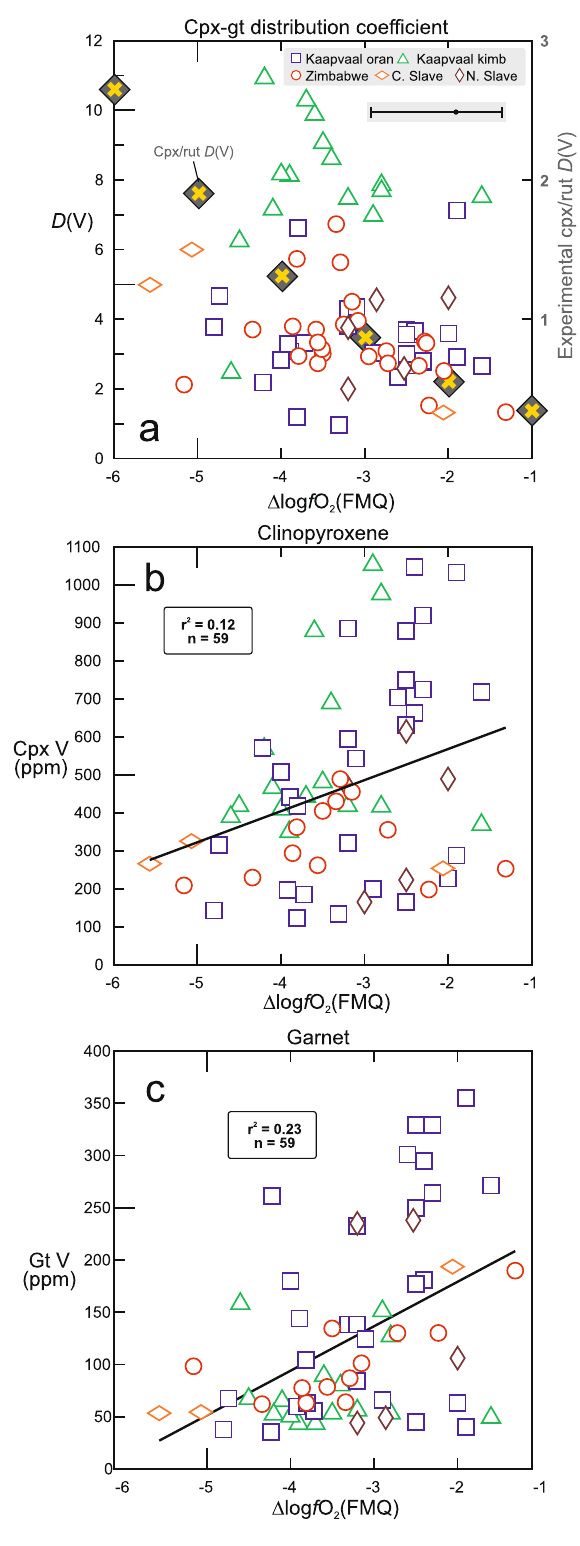
melt protoliths mimics that of natural MOR gabbros and MORB, save some reconstructed bulk eclogites from the Kaapvaal and northern Slave cratons showing anomalous V enrichment (Fig. 3a – b). These systematics are also recognisable in clinopyr-